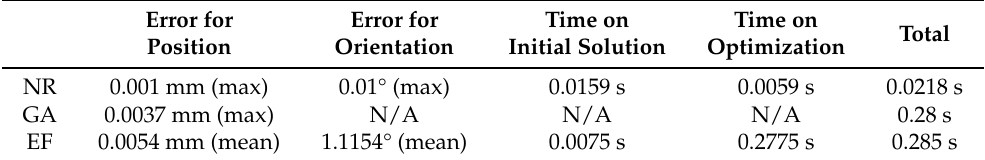
Table 10. Comparison of three error minimization